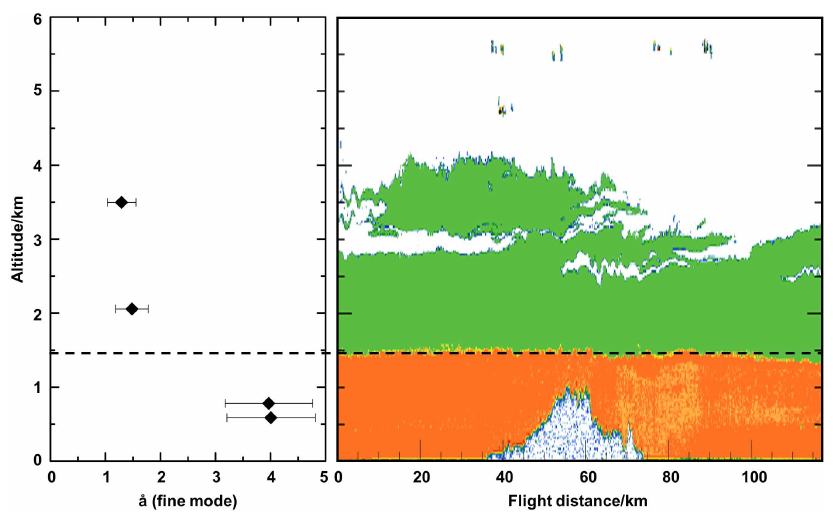
Fig. 10. Measurement example during SAMUM-2 on 25 January 2008. The left panel shows results of the in-situ measurements of the Angstrom exponent of absorption, the right panel shows the lidar signal, color-coded for the observed aerosol type (green for West-African biomass burning mixture, orange for mixed Saharan dust). Table 4. Summary of the key findings concerning the lidar ratio ( S p ) and the particle linear depolarization ratio ( δ p ) found in pure desert dust